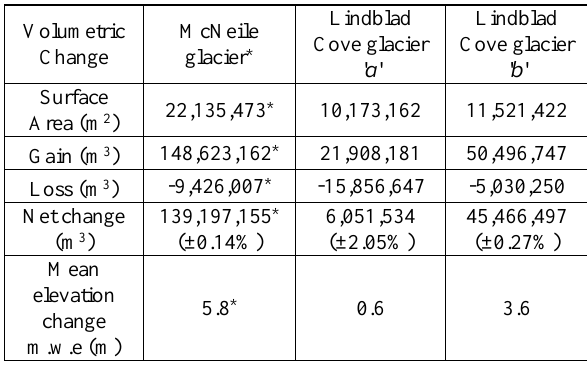
Table 6. Volumetric change between 1957 and 2014. * McNeile glacier volumetric change presented corresponds to the analysed 55% of the total glacier surface